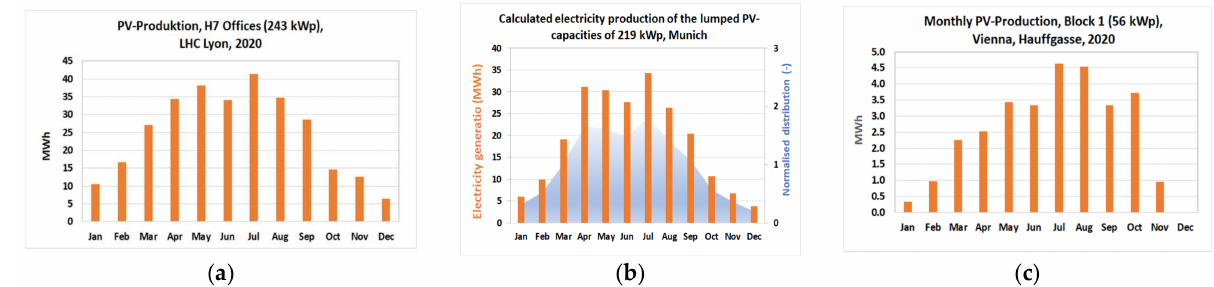
Figure 15. Monthly electricity production of the implemented roof-top PV panels selected among the three LHCs ( a ) in Lyon, ( b ) in Munich and ( c ) in